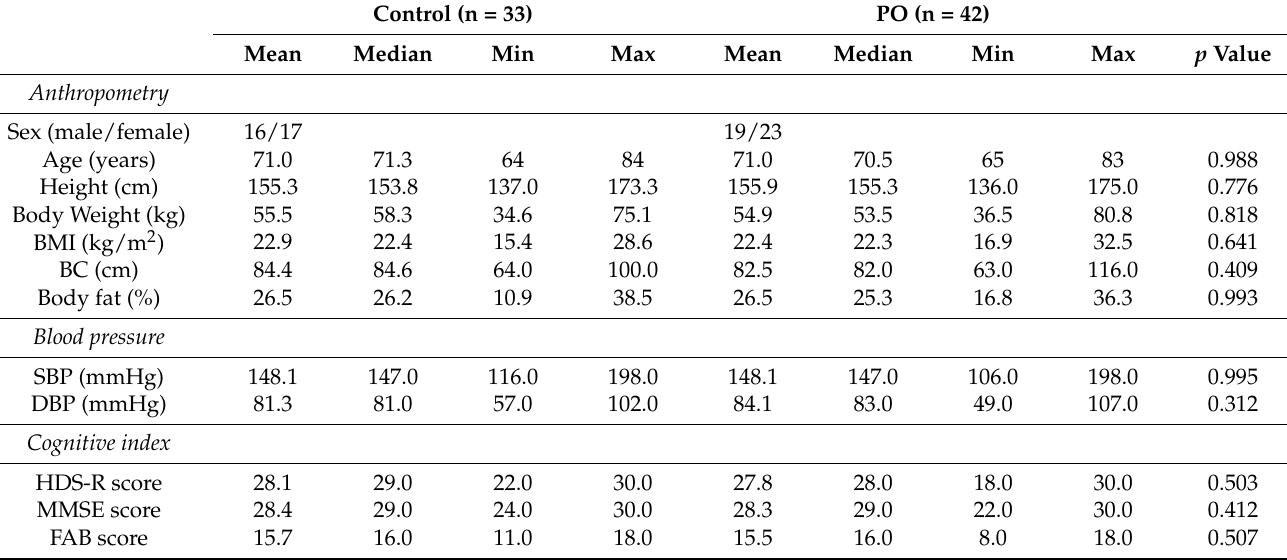
Table 2. Participants’ baseline